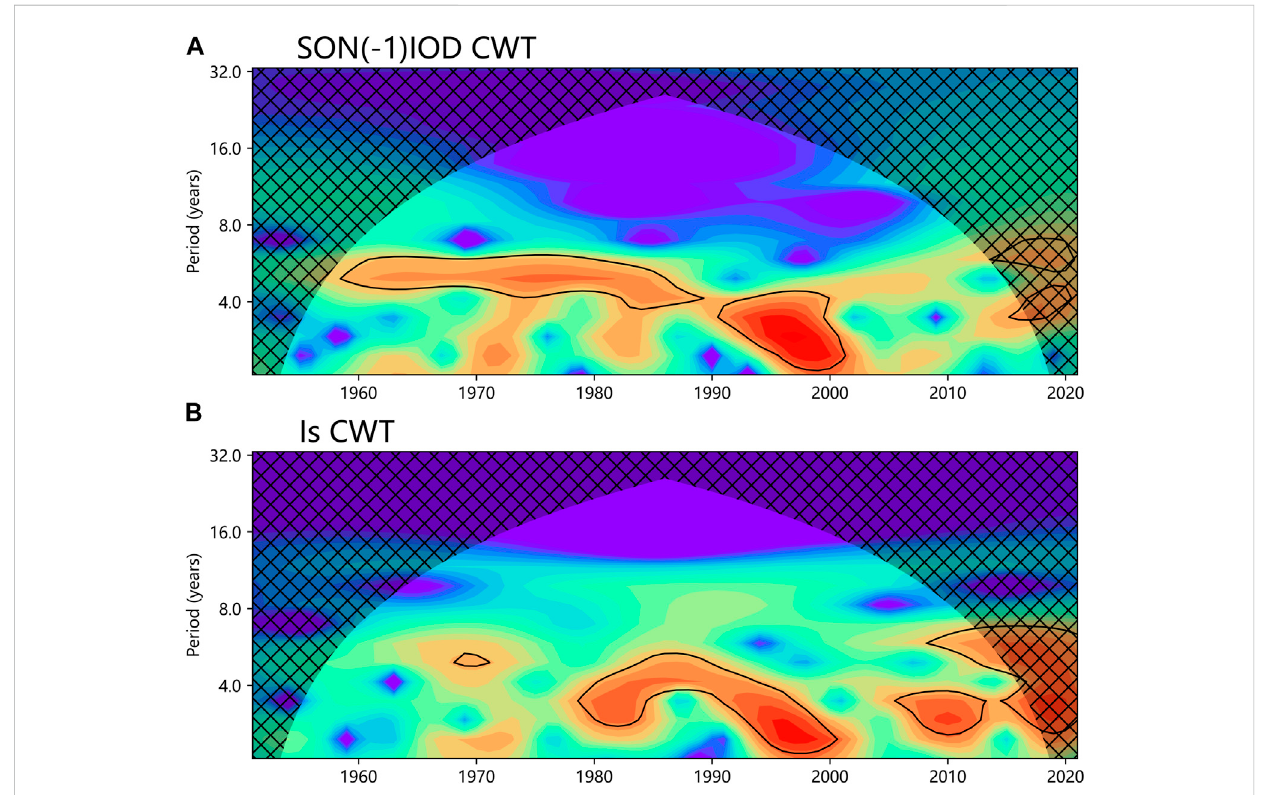
FIGURE 2 Wavelet power spectrum analysis of (A) the previous autumn IOD index (B) the SCSSM index; The range surrounded by a thick solid line is tested by thestandardspectrumofrednoiseatasigni fi cancelevelof0.05;theinvertedU-shapeisanin fl uenceconecurve(COI), andthepowerspectrumoutside this curve is not considered due to boundary